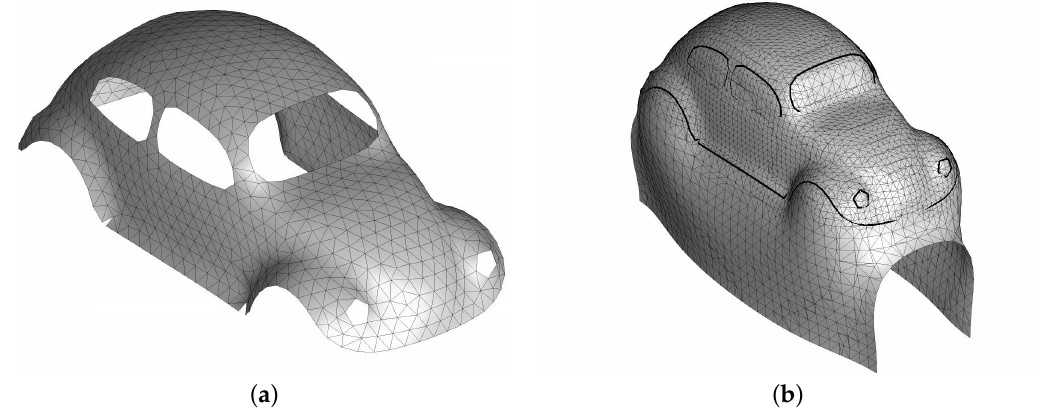
Figure 7. Raw mesh M and its underlying Poisson surface approximation M ∗ . ( a ) Original mesh M . ( b ) Poisson surface M ∗ underlying the raw mesh M ∗ .